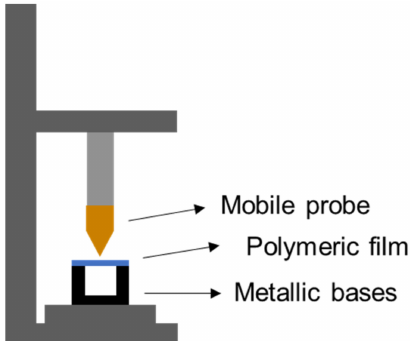
Figure 1. Schematic representation of the texture analyzer setup used to study the mechanical properties of films by recording the force at the breaks of